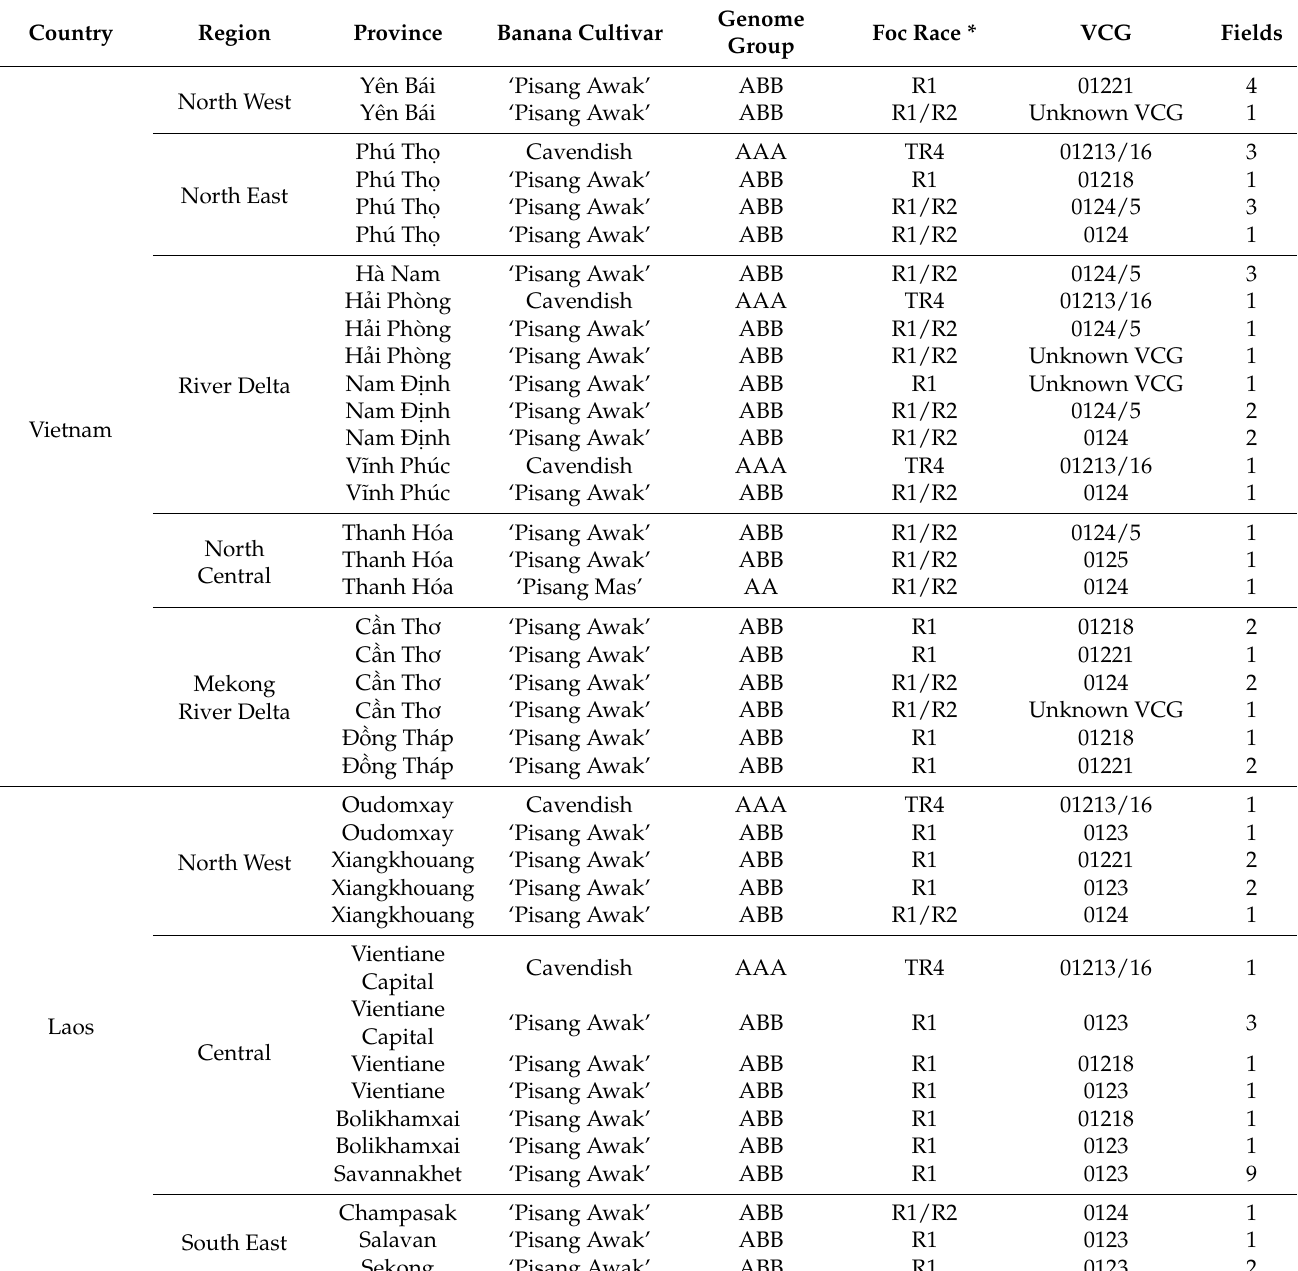
Table 3. Vegetative compatibility group (VCG) identification of Fusarium oxysporum f. sp. cubense during the 2020 survey. VCG and race identification of samples isolated from specific cultivars. The number of fields in which these VCG cultivar associations are found are indicated per